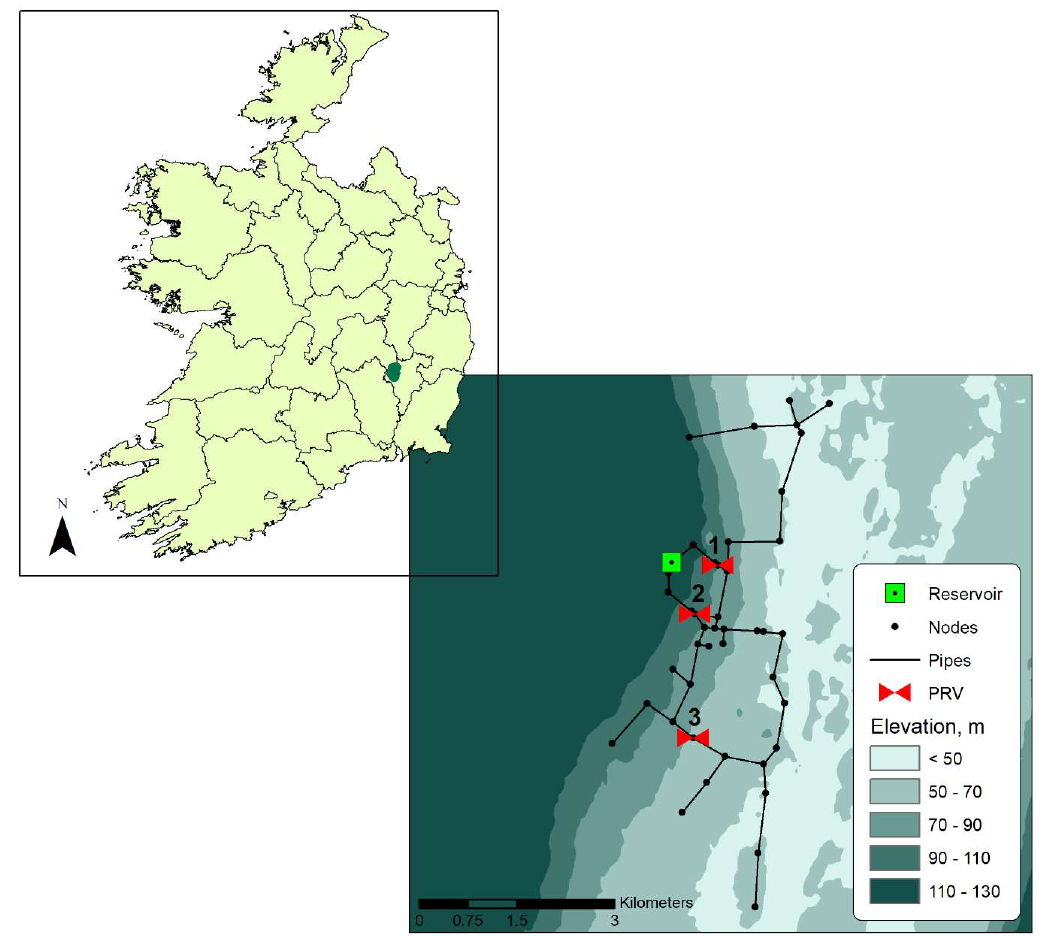
Figure 5. Ballinabranna water supply network layout.